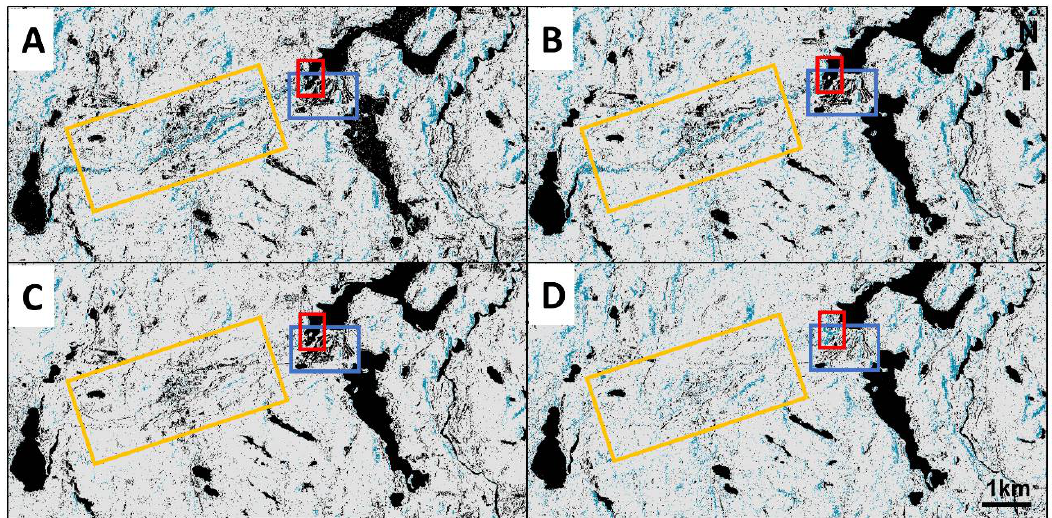
Figure 7. H-Alpha–Wishart classified models showing water (black), flooded vegetation (blue), and other (grey) for ( A ) 2 April 2016; ( B ) 24 April 2016; ( C ) 5 May 2016; and ( D ) 18 June 2016. Coloured boxes indicate example areas of change: blue—golf course misclassified as water; red—marshland dries out; yellow—flooded vegetation decreases, and misclassification of fields.